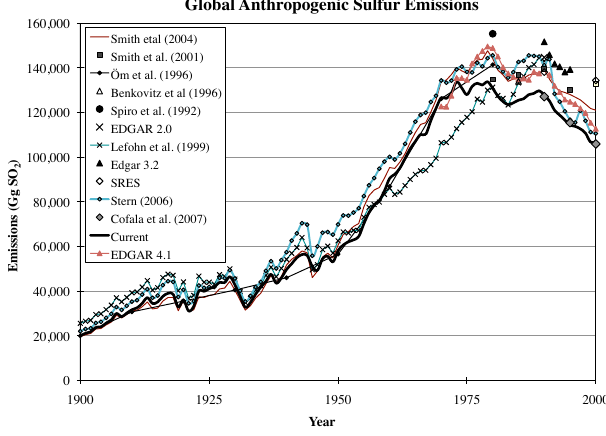
Fig. 8. Global sulfur emissions from this and previous studies: Cofala et al., 2007; GEIA (Benkovitz et al., 1996); Lefohn et al., 1999; ¨ Om et al., 1996; Smith et al., 2001, 2004; Spiro et al., 1992; SRES (Nakicenovic and Swart, 2001); Stern, 2006, EDGAR 2.0 (Olivier et al., 1996), EDGAR 3.2 (Olivier and Berdowski, 2001), and EDGAR 4.1 (JRC/PBL 2010). Open biomass burning emis- sions, where available, were not included in the totals shown. Co- fala et al. (2007) estimates adjusted to include international ship- ping as estimated here. The 2000 points from SRES and Smith et al. (2001) are shown as open symbols as these were projected emis- sions estimates made before year 2000 data were